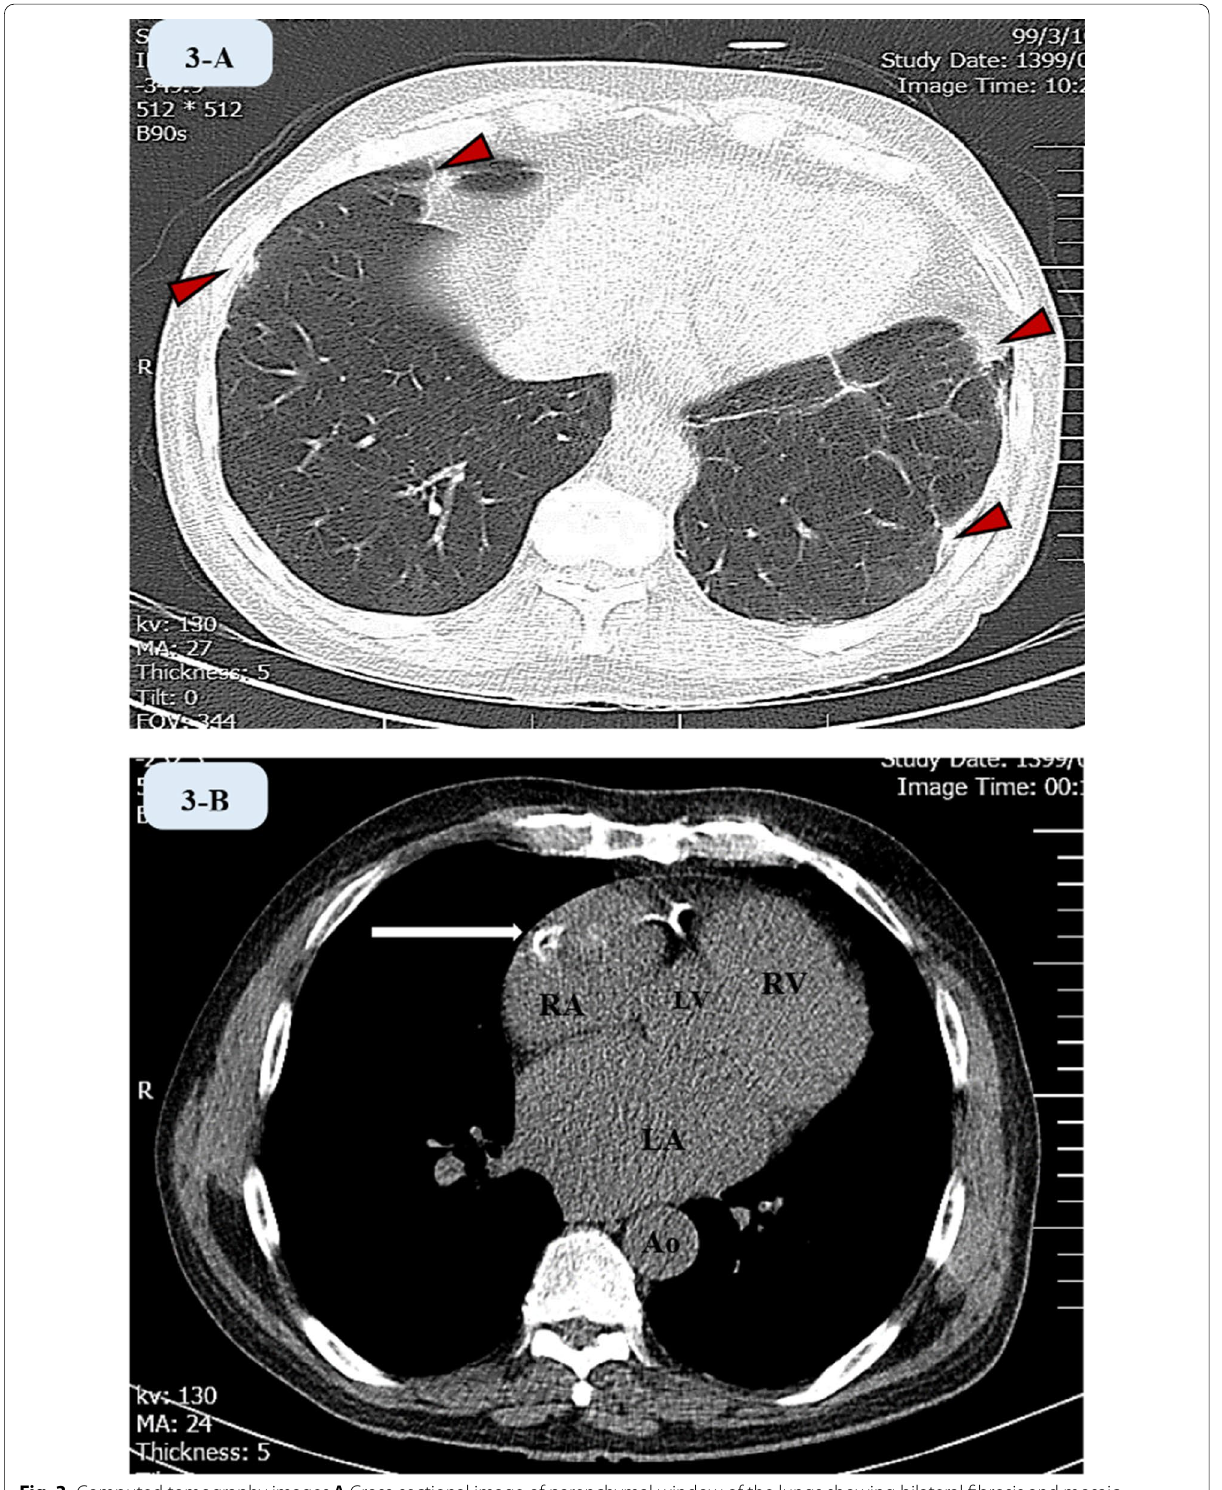
Fig. 3 Computed tomography images. A Cross‑sectional image of parenchymal window of the lungs showing bilateral fibrosis and mosaic pattern in both lungs with peripheral patchy ill‑defined ground glass densities in favour of COVID‑19 pneumonia (depicted via arrowheads). B Cross‑sectional CT scan of the heart and mediastinum at the level of atria showing biatrial enlargement and a calcified space‑occupying mass in RA (arrow). CT: computed tomography, LV: left ventricle, RV: right ventricle, LA: left atrium, RA: right atrium, Ao: descending